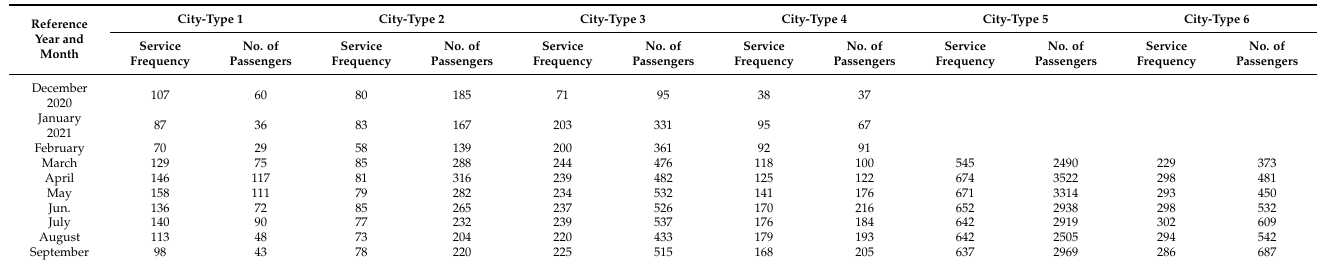
Table 2. Service frequency and the number of passengers by route and month (internal data of